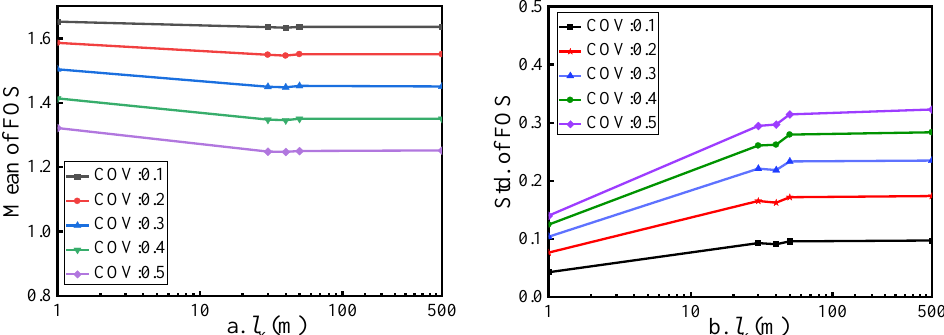
Figure 15. FOS vs. l x for different COVs (WL = 5 m) (( a ) The Mean of FOS for five different COVs; ( b ) The Std. of FOS for five different COVs).